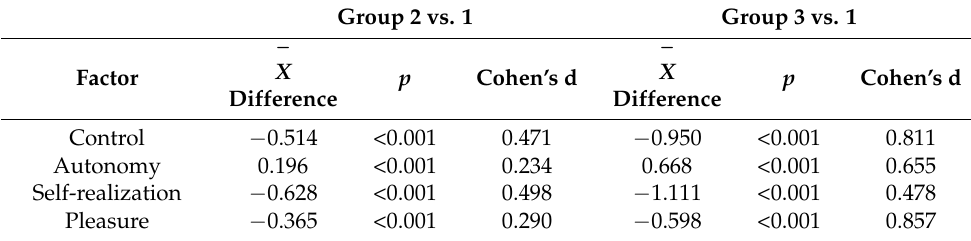
Table 4. Latent mean differences and effect size estimators. Group 2 vs. 1 Group 3 vs.